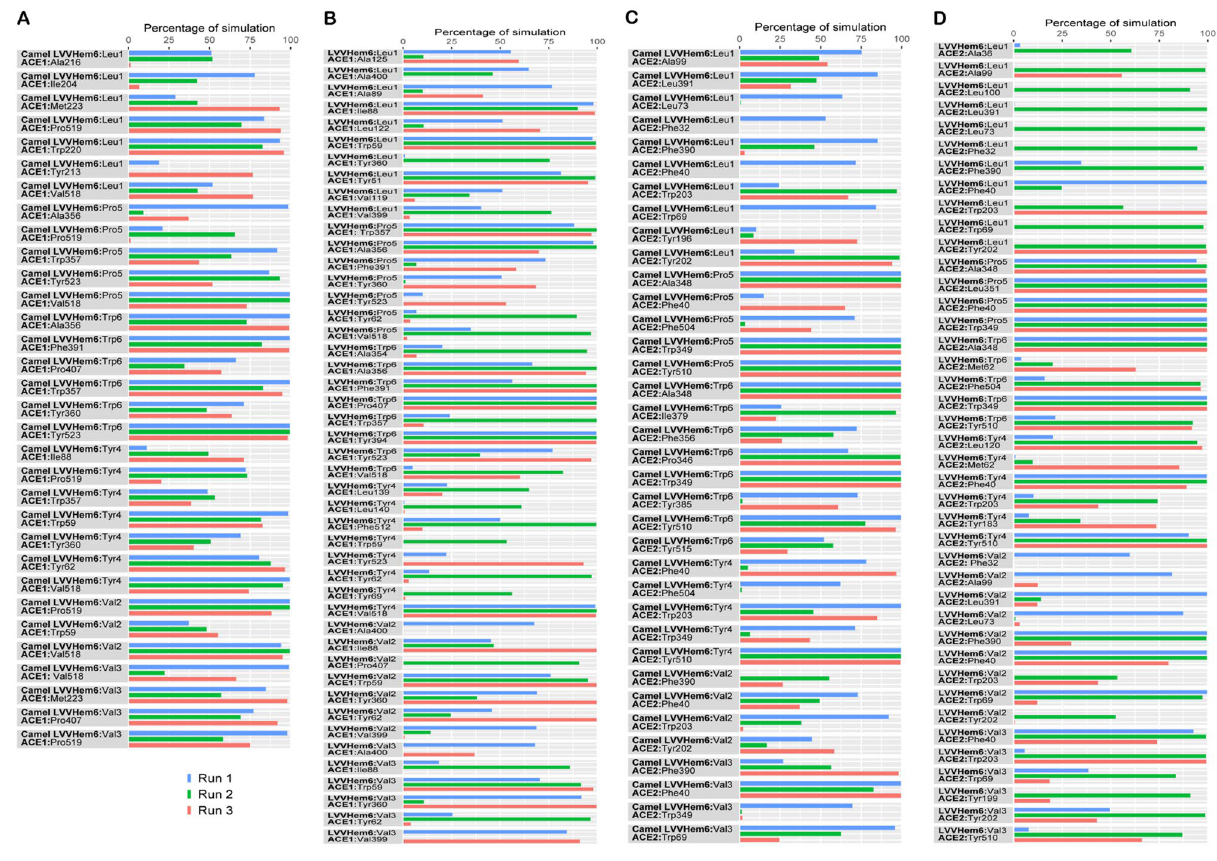
Figure 7. Percentage of contact time during hydrophobic interactions between ACE1 and ACE2 proteins and hemorphin peptides. ( A ) Camel LVVHem6 with ACE1 ( B ) LVVHem6 with ACE1 ( C ) Camel LVVHem6 with ACE2 ( D ) LVVHem6 with